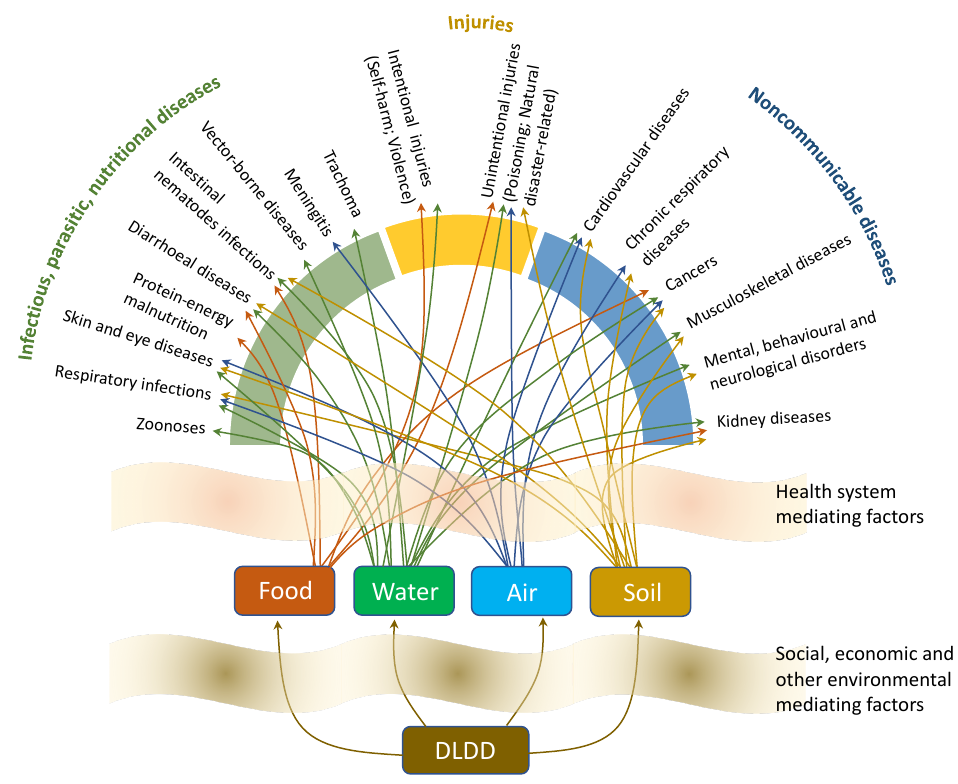
Figure 1. Desertification, land degradation and drought (DLDD) pathways and health effects; Source: